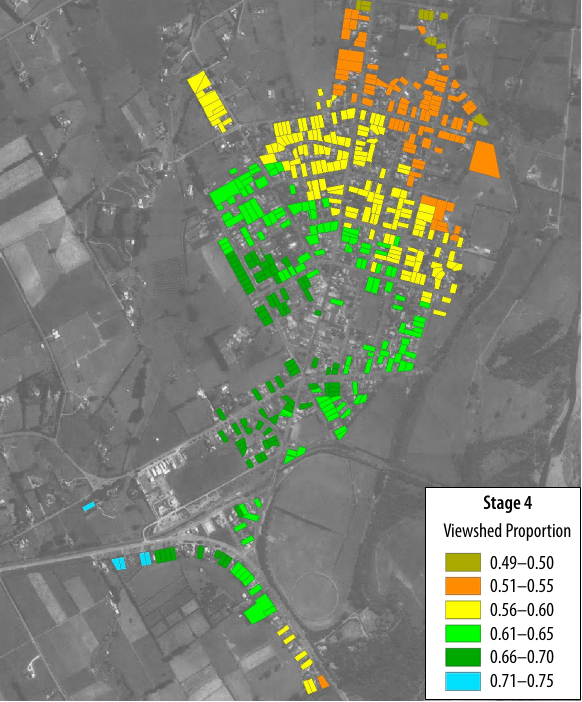
Fig. 3. Ashhurst house sales within the